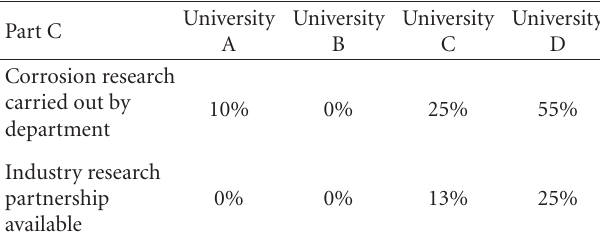
Table 8: Resources: